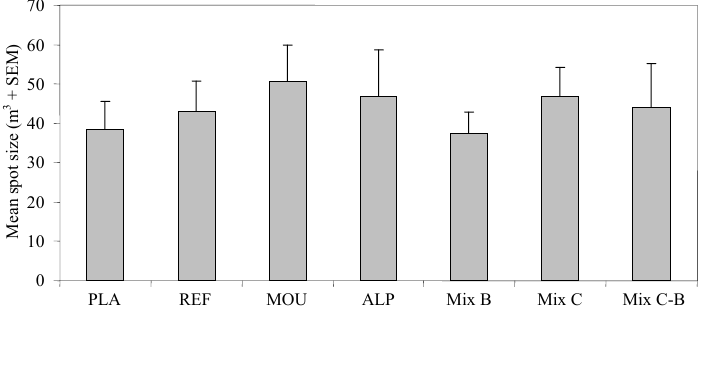
Figure 4. Mean size (m 3 ) of the infestation spots recorded in different spruce forest types. For the code legend, see Table